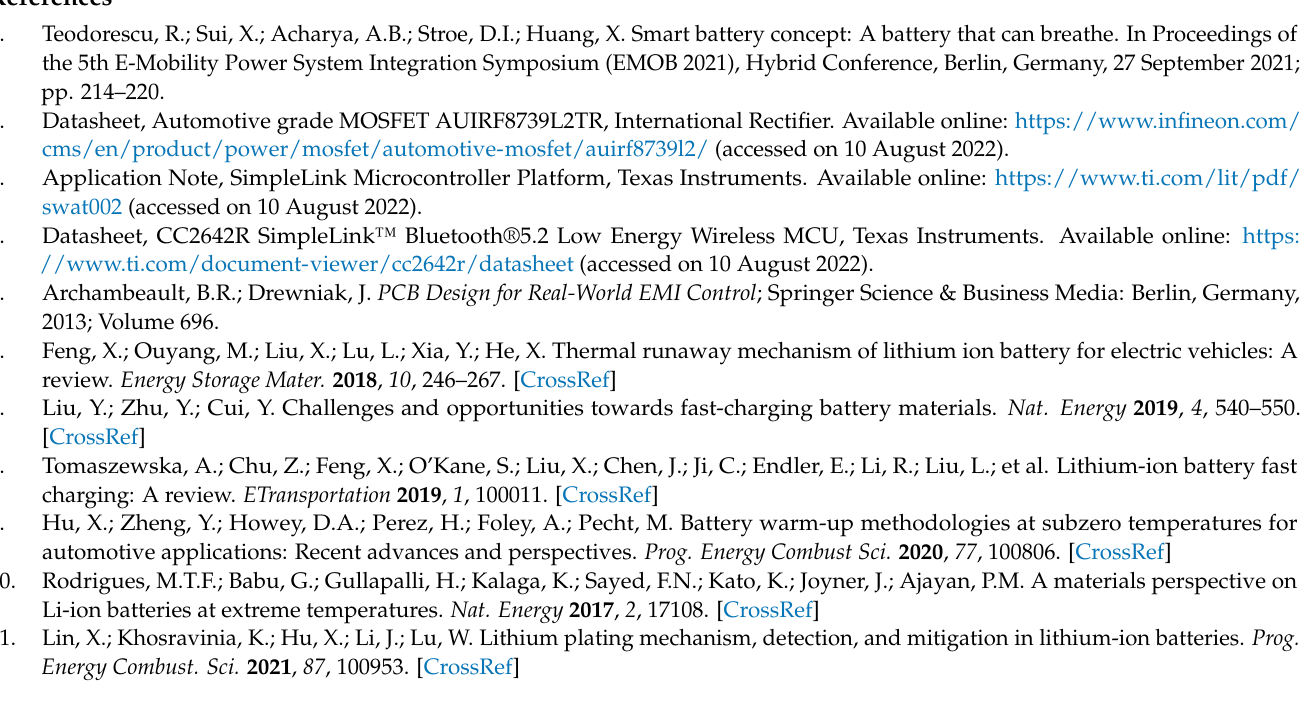
Figure 15. The performance-optimized Smart Batteries find applications in energy storage for modern power grids and green microgrids. They can also be readily applied in maximum power point tracking in photovoltaic applications by acting as a controlled voltage source. With the fast-growing EV industry, the role of a high-performing Smart Battery is inevitable for fast charging and lifetime extension, which is also applicable to the electric aircraft industry. The second lifetime of batteries is the sustainable way of reusing EV batteries in residential energy storage with reduced capacity fade using the Smart Battery